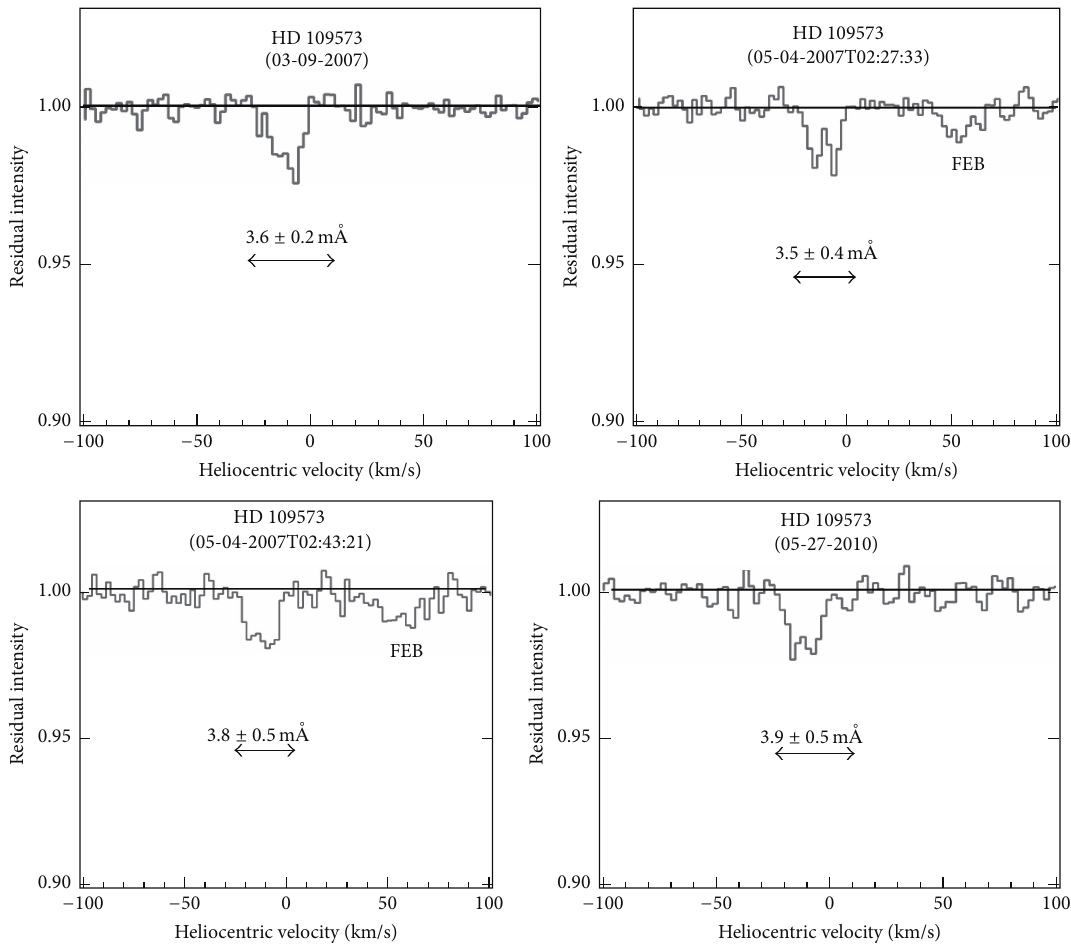
Figure 7: Four archival circumstellar CaII K-line absorption spectra of HD 109573 recorded with the ESO FEROS spectrograph on 3 nights within a two-month period in 2007 and one night in 2010. Note the appearance and disappearance of an FEB absorption event at 𝑉 ∼ +60 kms −1 that appeared in two spectra during the night of